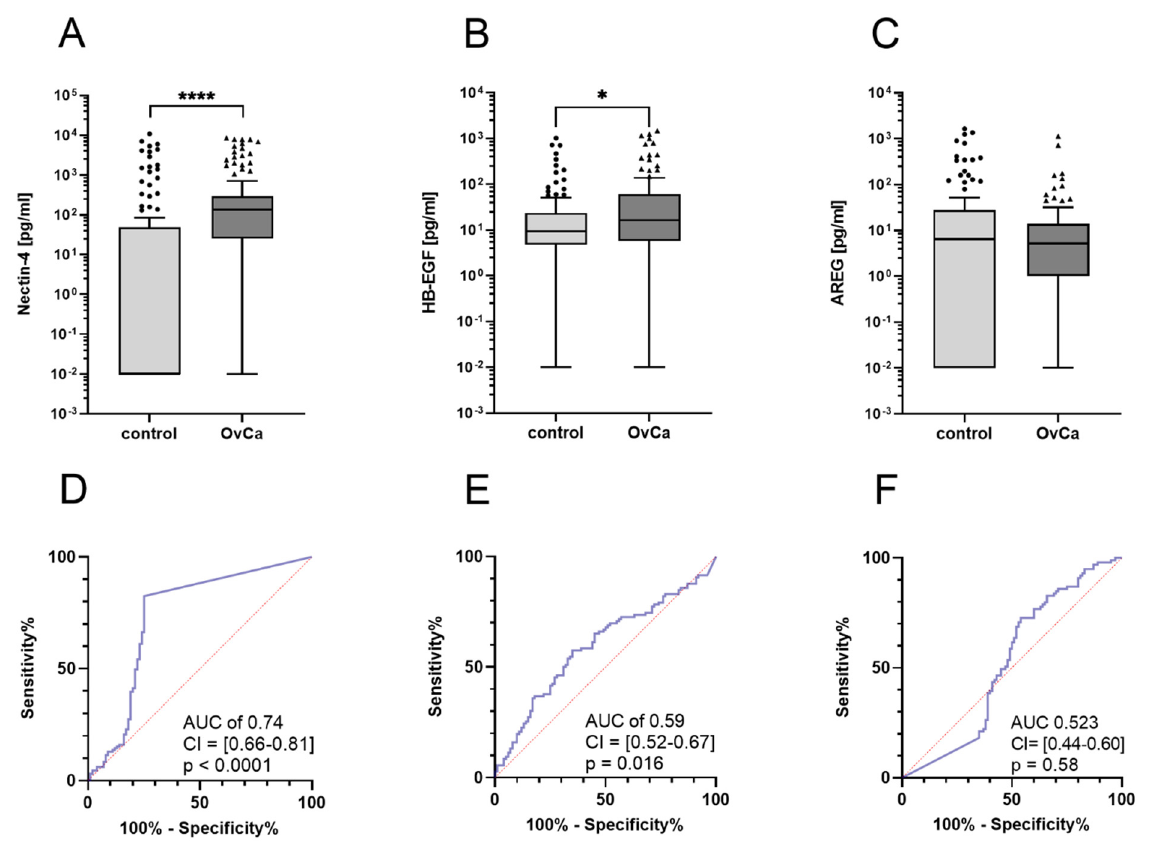
Figure 1. Boxplots of Nectin-4, HB-EGF and AREG levels at primary diagnosis. ( A ): Nectin-4 is elevated in OvCa patients, Mann–Whitney test **** ( p < 0.0001). ( B ): HB-EGF is increased in OvCa patients, Mann–Whitney test * ( p = 0.016). ( C ): AREG levels of the patient cohort and the control group were similar, Mann–Whitney test ( p = 0.57). ( D ): Receiver operating characteristic (ROC) of Nectin-4. ( E ): ROC curve of HB-EGF. ( F ): ROC curve of AREG.